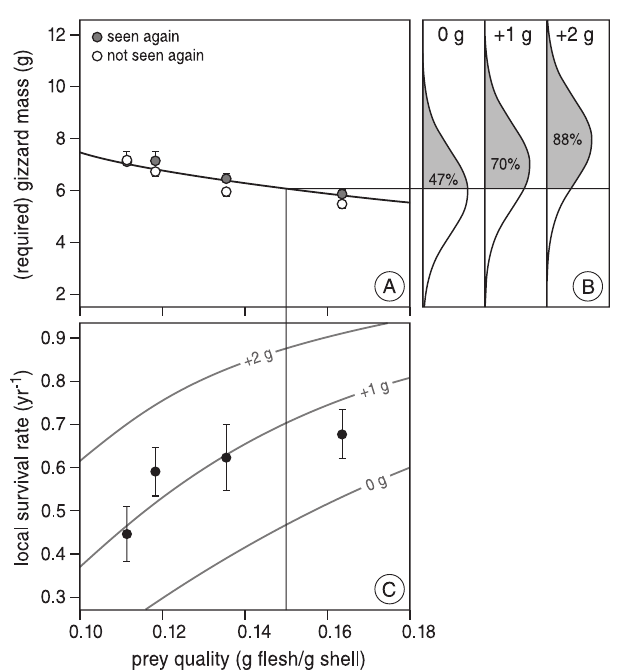
Figure 4. Quantitative Relations between Prey Quality, Gizzard Mass, and Local Survival Rate (A) Gizzard mass required to maintain energy balance declines as a function of prey quality (solid line). Gizzards of birds seen again after catching fit this relationship (gray dots; mean 6 SE), whereas gizzards of birds not seen again are significantly smaller (open dots; note that both groups almost entirely overlap in the poorest-quality year). (B) Observed gizzard masses upon arrival are distributed according to the left-most normal distribution. If there were no room for flexibly adjusting gizzard mass (0 g), only 47% of the arriving knots would be able to avoid starvation (shaded area) at an example prey quality of 0.15 g flesh per g shell (dashed line). If there were room for flexibility ( þ 1 and þ 2 g in this example), a much larger proportion would be able to survive (respectively 70% and 88%). (C) Observed local survival rate (y (cid:3) 1 ; 6 SE) increased as a function of prey quality and best matched with predicted survival in a þ 1-g flexibility scenario. DOI: